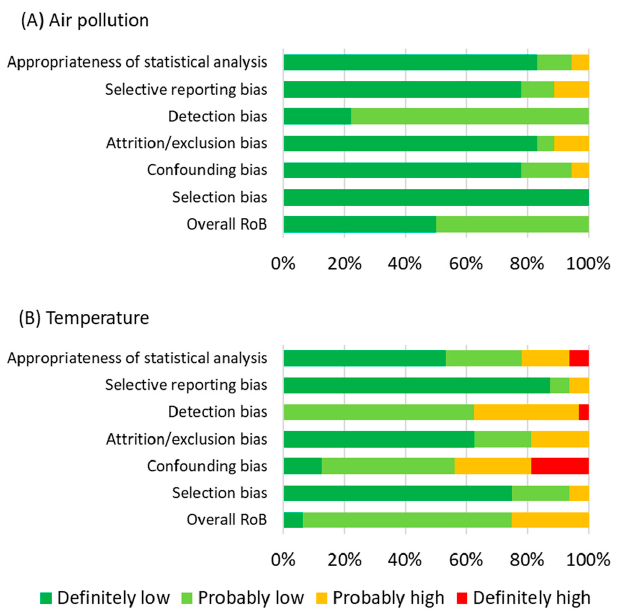
Figure 4. Percent of the included studies by overall risk of bias (RoB) and levels of risk of bias for six criteria: ( A ) air pollution, ( B ) temperature. criteria: ( A ) air pollution, ( B )